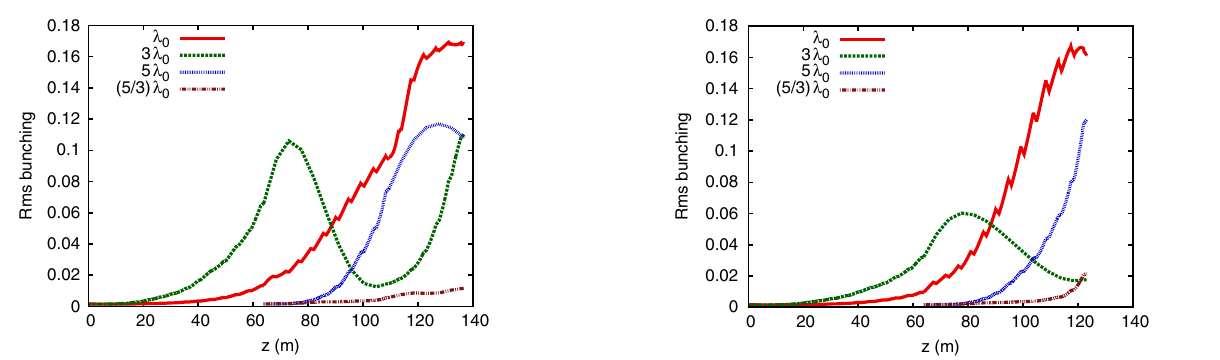
FIG. 10. Rms bunching parameter at various wavelengths as a function of distance for the nominal configuration with reduced energy spread and increased emittance.